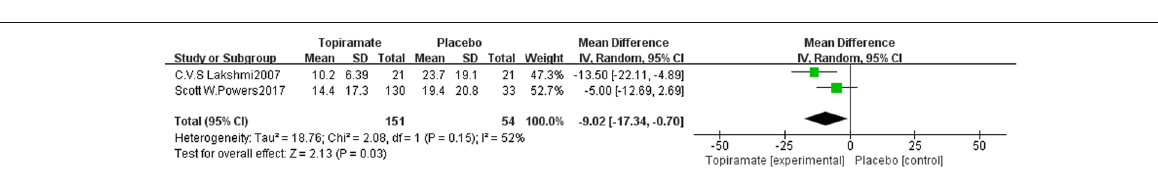
Fig. 5 Forest plot of comparison: PedMIDAS score of topiramate versus placebo